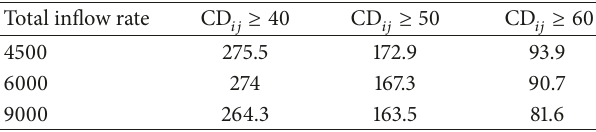
Table 2: The relationships between the number of cells with high cumulative density and total inflow